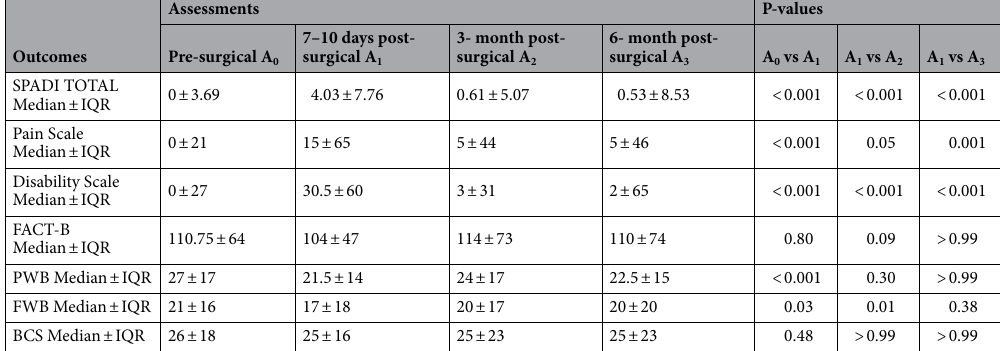
Table 3. Perceived shoulder pain and disability and health related quality of life between baseline measurement and different follow-ups. VAS Visual Analog Scale, X mean, SD standard deviation, IQR interquartile range, PWB physical well being, FWB functional well being, BCS breast cancer